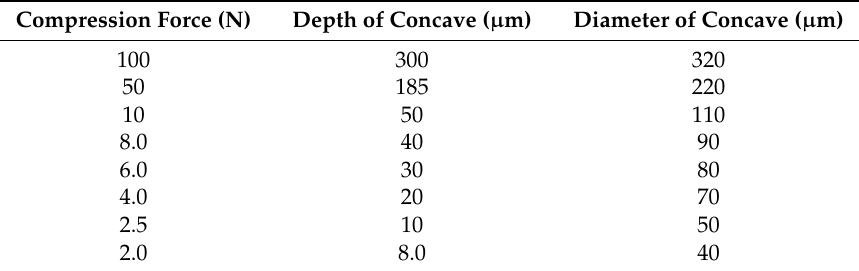
Table 2. Variation of concave dimensions with applied